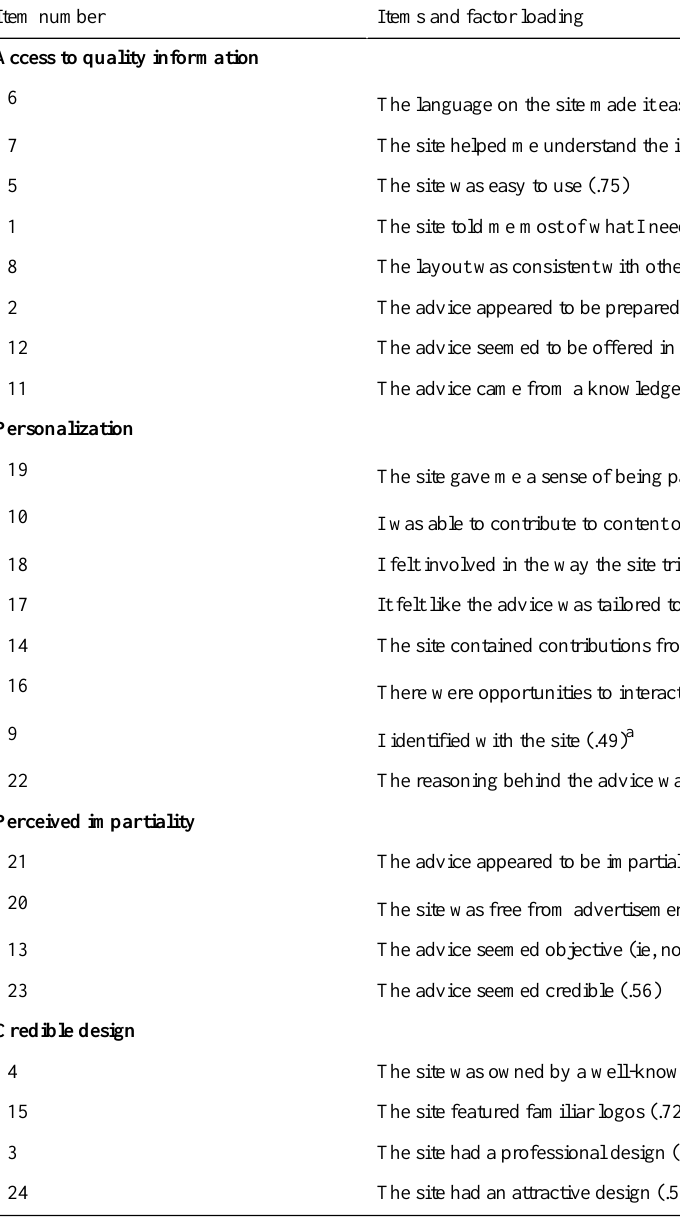
Table 2. Four factors on the general Web trust questionnaire and items with loading on the relevant factor Access to quality